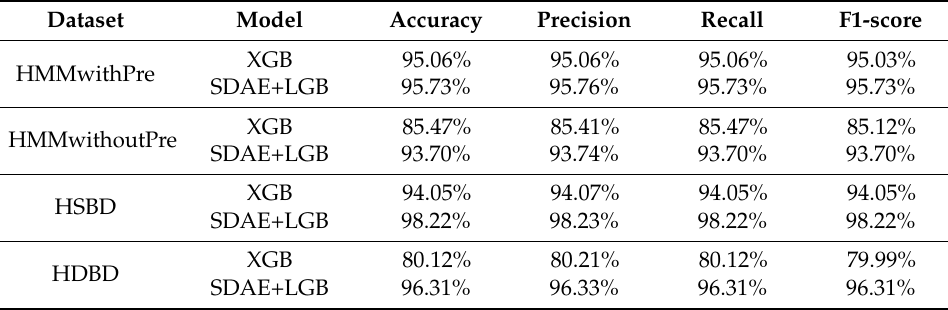
Table 10. The evaluation score of XGB on four datasets.